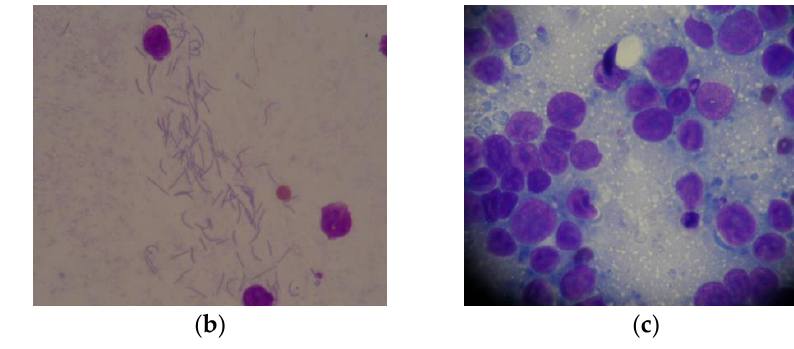
Figure 2. ( a ) Endoscopic appearance of the abnormal gastric mucosa; areas of mucosal proliferation and bleeding were seen giving the mucosa a ‘cobblestone’ appearance ; ( b ) impression smear demonstrating multiple spiral-shaped organisms suggestive of Helicobacter-like organisms (×100); ( c ) impression smear demonstrating medium lymphocytes, with dense chromatin clumping, and multiple nucleoli (×400).